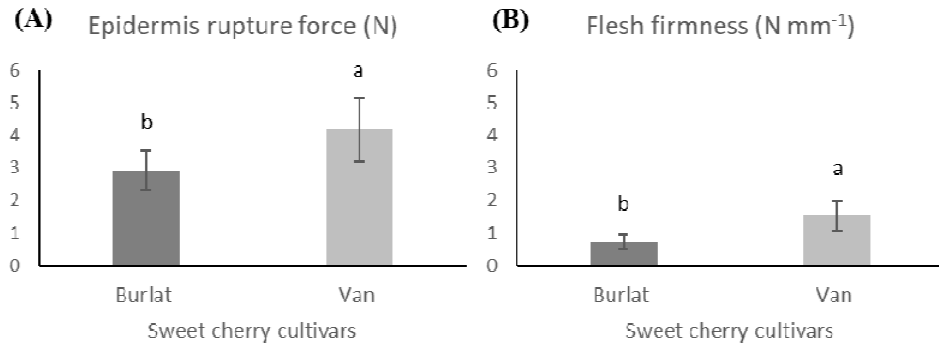
Figure 4. Texture of the two sweet cherry cultivars (Van and Burlat): ( A ) Epidermis rupture force—ERF (N) and ( B ) Flesh firmness—FF (N mm −1 ). The presented values resulted from the mean ± SD ( n = 30). Statistically significant differences between cultivars, for each parameter, were represented by different letters (ANOVA-Tukey’s test, p < 0.05).